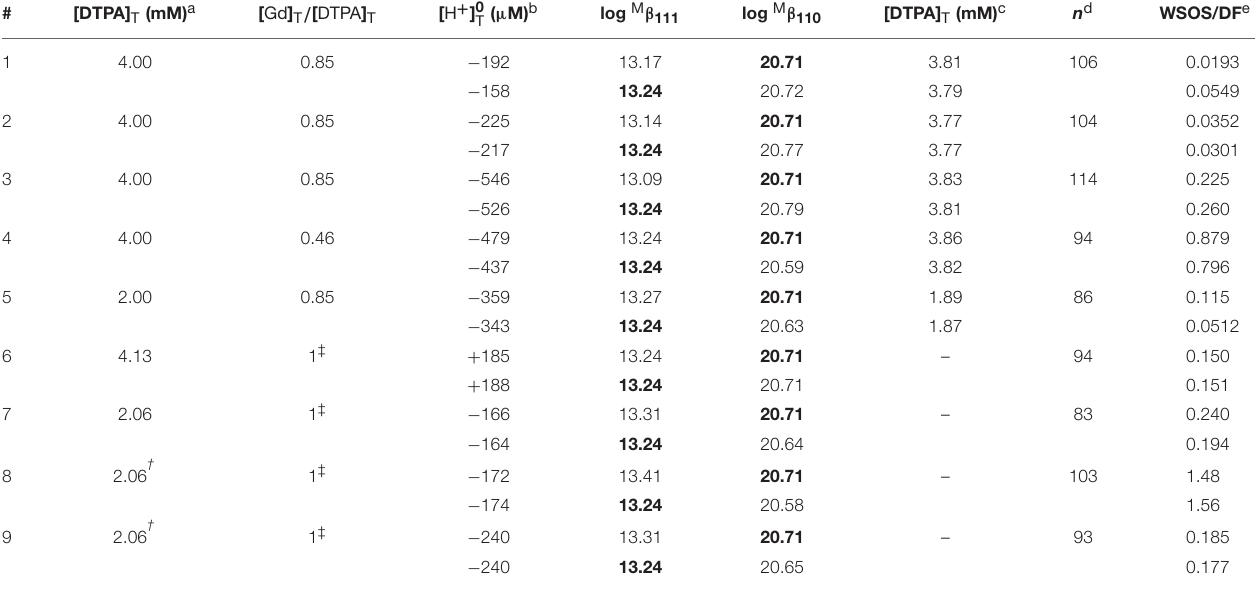
TABLE 6 | Nine titrations of gadolinium in 0.7M NaClO 4 solutions containing